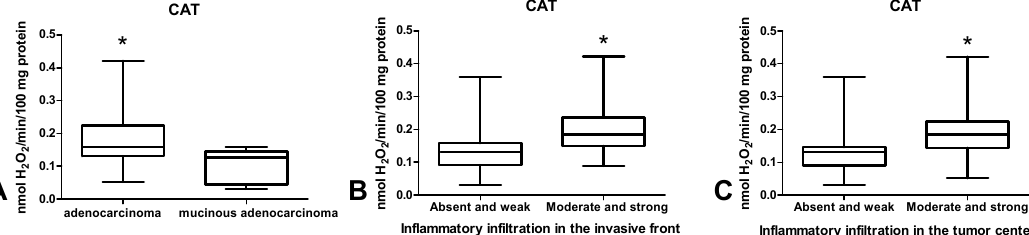
Figure 5. Comparison of: CAT activity ( A ) between adenocarcinoma and mucinous adenocarcinoma; CAT activity depending on the intensity of inflammatory infiltration in the invasive front ( B ) and centre ( C ) of the tumour. The data are presented as median (minimum–maximum). Abbreviations: CAT—catalase. * p < 0.05.